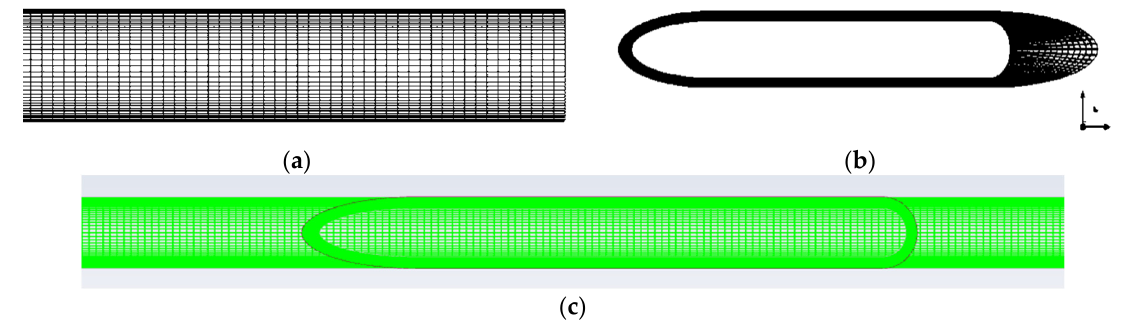
Figure 5. Background and overset grid concept; only a fraction of the tube domain is shown. ( a ) 75 × 7500 background grid (stationary); ( b ) 50 × 200 moving domain (overset domain); ( c ) overlaying the overset domain on the background domain.